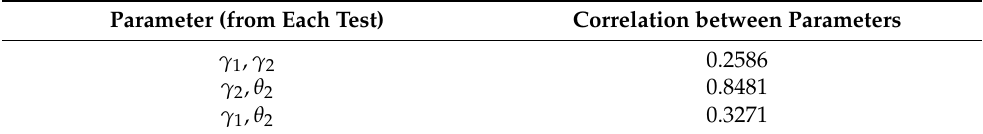
Table 2. The correlation matrix between model parameters for all results.